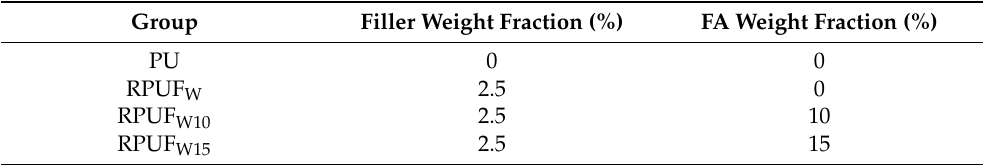
Table 1. Nomenclature of the studied